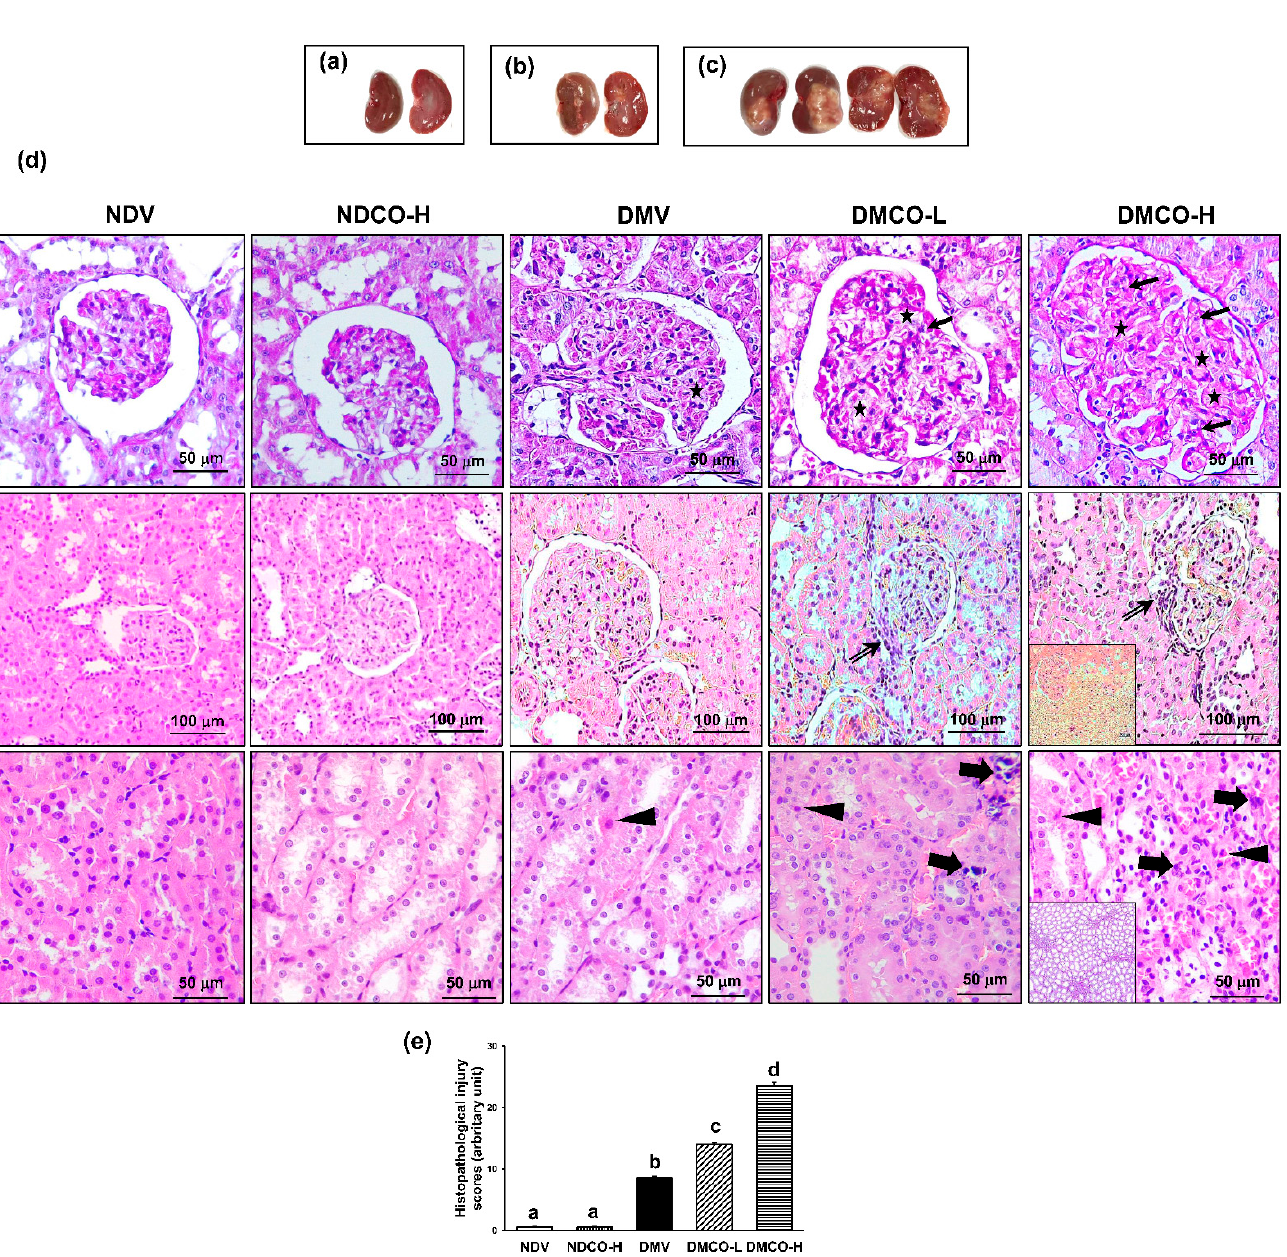
Figure 3. Effects of crocodile oil on renal structural changes at the age of 40 weeks: ( a – c ) gross findings of kidneys with cross-sectional view; ( d ) histological alterations with PAS (upper row, 40×) and H&E staining (glomeruli in middle row, 10×, and renal tubules in lower row, 40×) showing endothelial cell proliferation (arrow), matrix accumulation (star), perihilar mesangial cell proliferation (double arrow), apoptotic cell (triangle), inflammatory cell infiltration (block arrow), appearance of abnormal cells (inset, H&E staining), and interstitial fibrosis (inset, PAS staining) within DMCO-H. ( e ) Histopathological injury score: values are mean ± SEM (n = 3 each). NDV: nondiabetic treated with vehicle; NDCO-H: nondiabetic treated with high-dose crocodile oil; DMV: diabetic treated with vehicle; DMCO-L: diabetic treated with low-dose crocodile oil; and DMCO-H: diabetic treated with high-dose crocodile oil. Different lowercase letters denote statistical differences at p < 0.05 between groups.